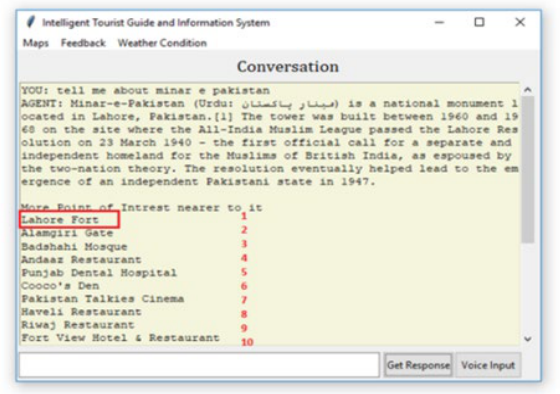
Fig. 6. Comunication with the agent.